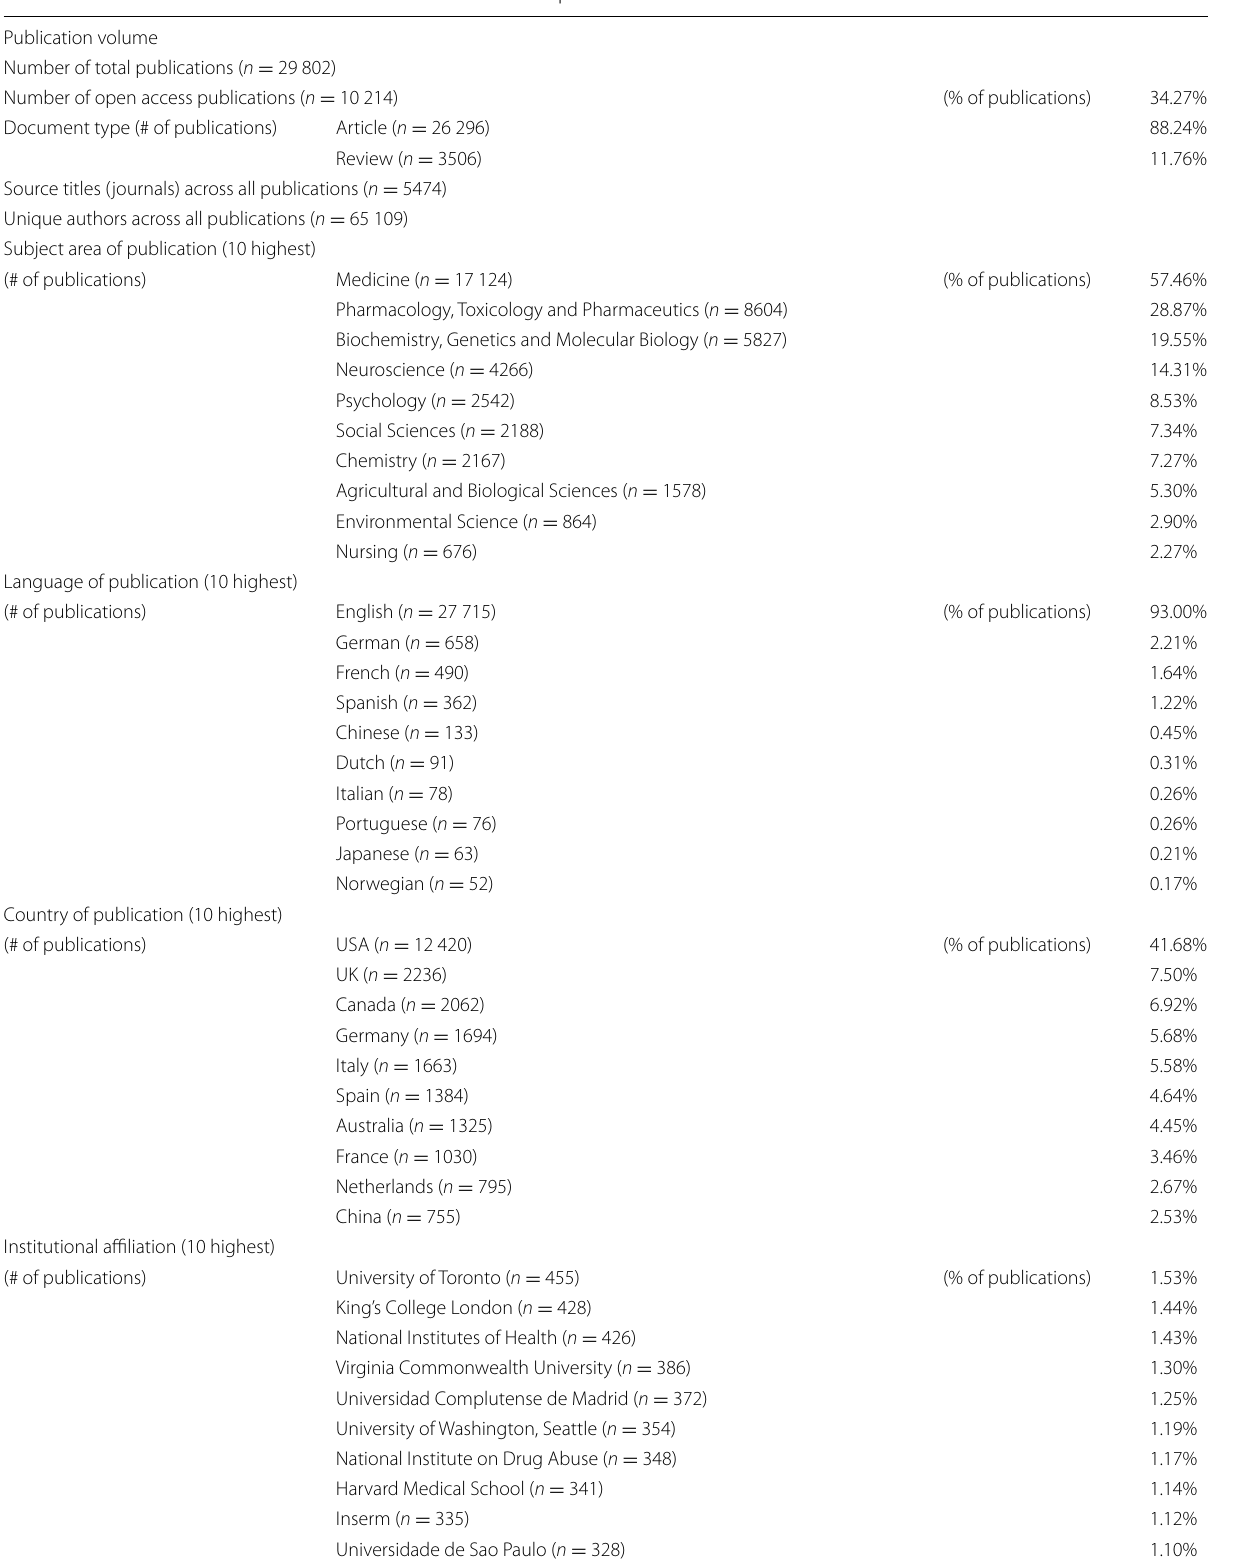
Table 2 General characteristics of cannabis and cannabinoid